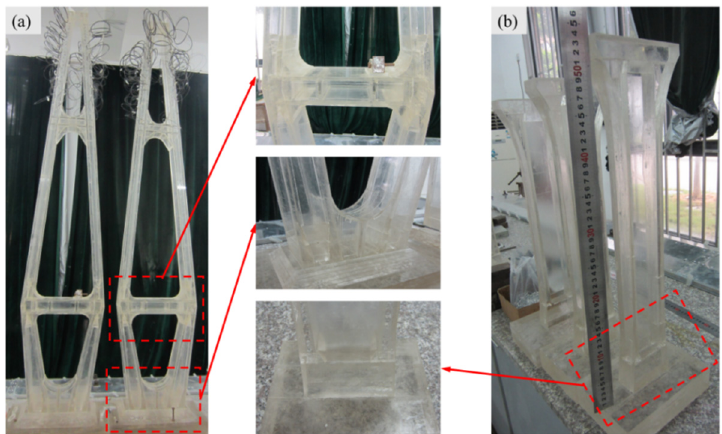
Figure 3. Detailed design of testing specimen ( a ) towers and ( b ) piers.